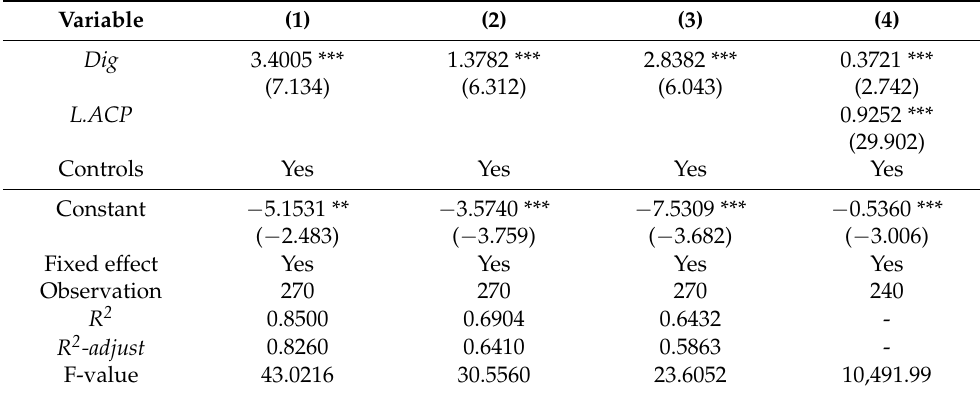
Table 6. Robustness test of the benchmark regression results.